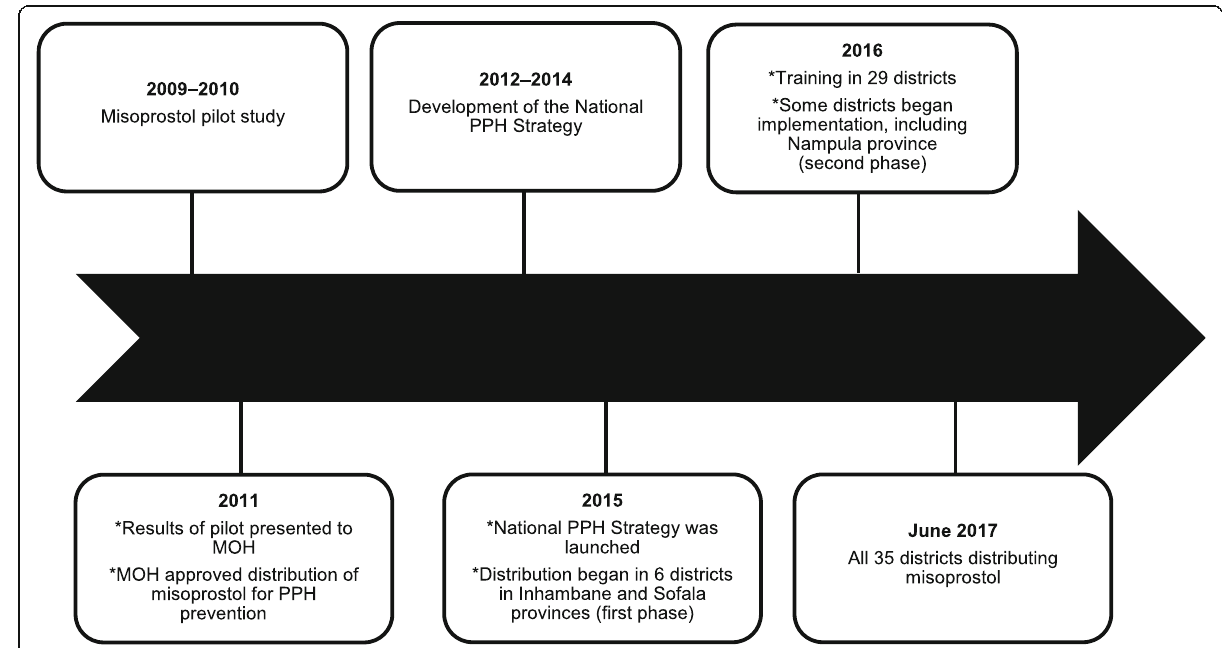
Fig. 2 The Evolution of the Distribution of Misoprostol for Prevention of Postpartum Hemorrhage in Mozambique (Figure developed by K. Hobday and was published in Hobday et al., 2019 [22] which is an open access